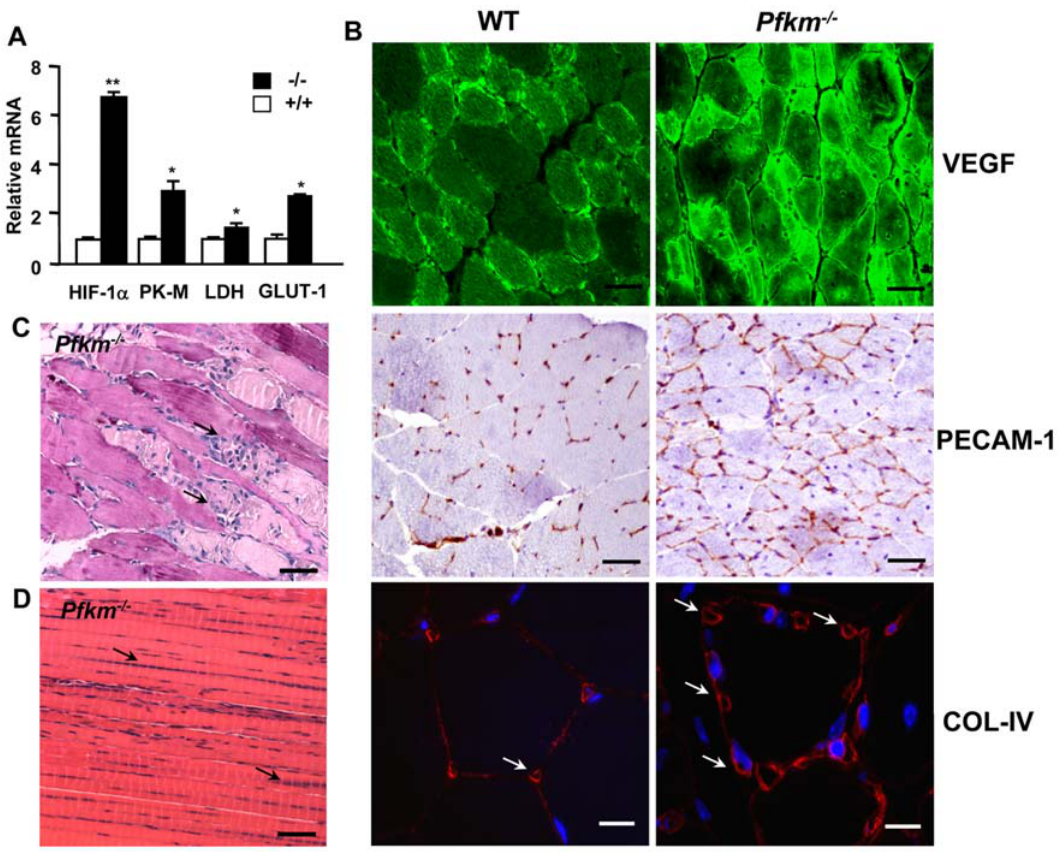
Figure 7. Pfkm 2 / 2 mice show increased skeletal muscle hypoxic markers, vascularization, and fiber necrosis. (A) The expression of the hypoxia-induced factor (HIF-1 a ), pyruvate kinase (PK-M), lactate dehydrogenase (LDH), and glucose transporter-1 (GLUT-1) in skeletal muscle of Pfkm 2 / 2 mice was determined by quantitative PCR analysis, as indicated in Materials and Methods. Results are mean 6 SEM of four mice per group. * P , 0.05, ** P , 0.01 vs. wild-type. (B) Skeletal muscle sections showed increased immunostaining for VEGF, leading to hypervascularization, as evidenced by greater immunostaining for endothelial cell marker PECAM-1 (scale bar 25 m m) and collagen IV (scale bar 10 m m). Arrows show blood vessels around muscle fiber. (C) Fiber necrosis in skeletal muscle sections of Pfkm 2 / 2 mice. Arrows indicate cell infiltration of necrotic fibers (scale bar 25 m m). (D) Muscle fiber regeneration is evidenced by multiple centrally located nuclei (arrows) (scale bar 25 m m).